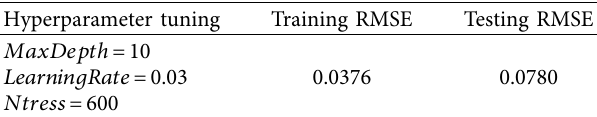
Table 4: GBM hyperparameter tuning and modeling performance. Hyperparameter